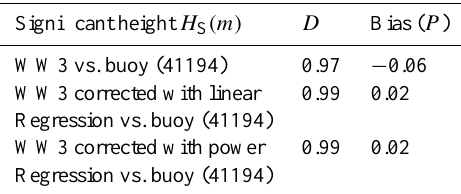
correction of the WW3 H s series from the 15 points selected for the analysis.